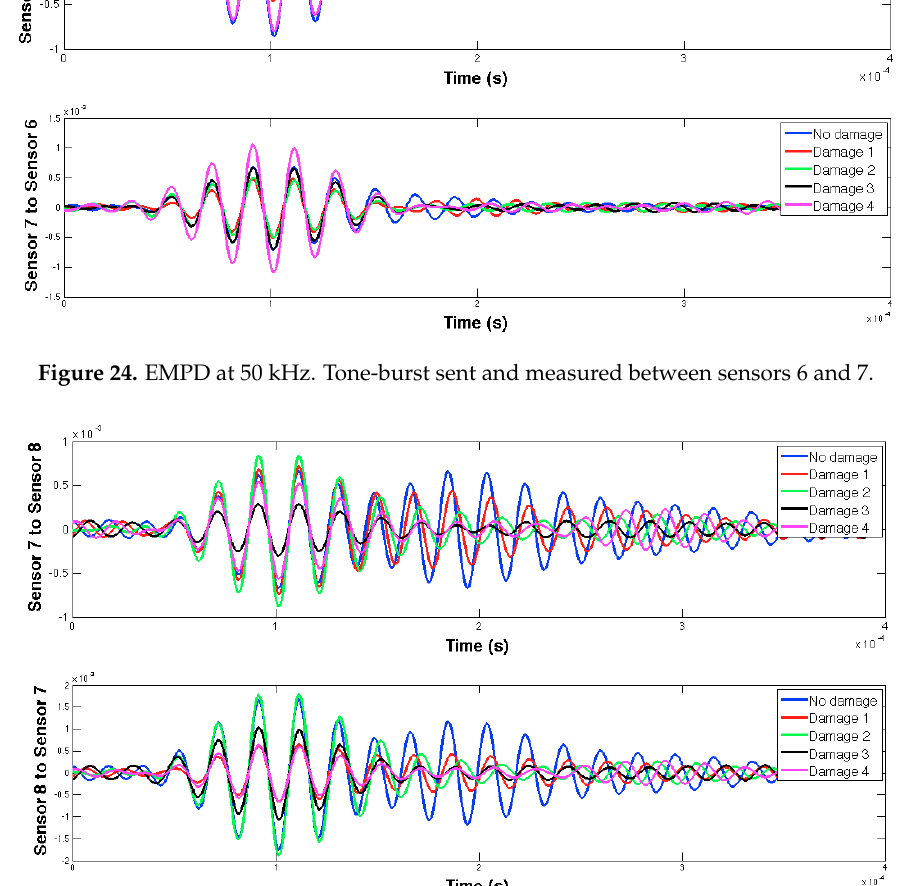
Figure 25. EMPD at 50 kHz. Tone-burst sent and measured between sensors 7 and 8.